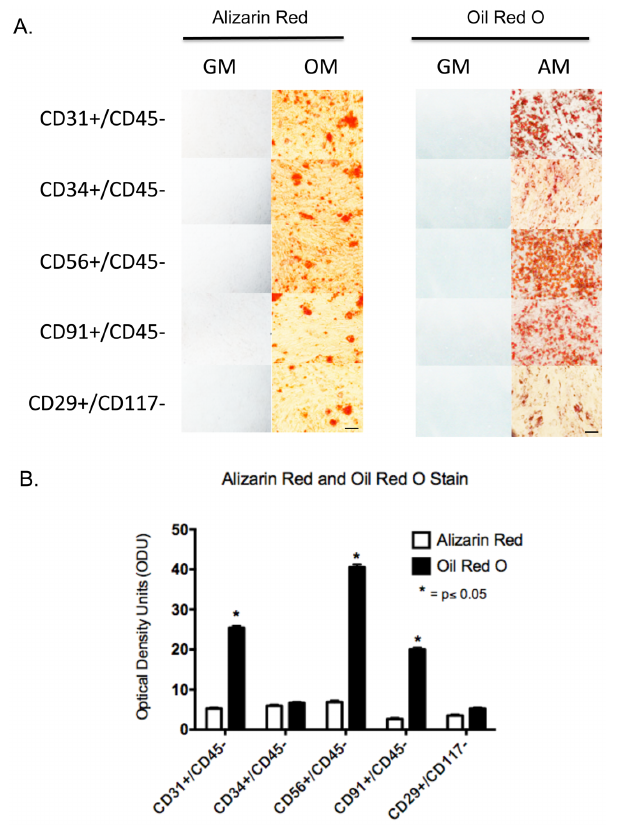
Fig. 8. Osteogenesis and adipogenesis of CD29 + , CD31 + , CD34 + , CD56 + and CD91 + cells. A. Flourescent-conjugated antibodies to CD29, CD31, CD34, CD56 and CD91 were used to separately sort and subculture cells form collagenase 2 digested human muscle. The cells were cultured to confluence then the cells were cultured for an additional three weeks in either osteogenic media (OM), adipogenic media (AM) or regular growth media (GM). The cultures were fixed and processed for Alizarin Red or Oil Red O staining. Scale bar 5 100 m m. B. For each marker the bar graph reflects the number of optical density units (ODU) (mean ¡ SEM, n 5 5), as measured with Image J, for Alizarin and Oil Red O staining of isolated cell types differentiated in osteogenic media (OM) and adipogenic media (AM). Significant difference is observed (*) in Oil Red O staining between CD34 and CD29 compared to CD31, CD56, and CD91 (Student’s t-test, p # 0.05).